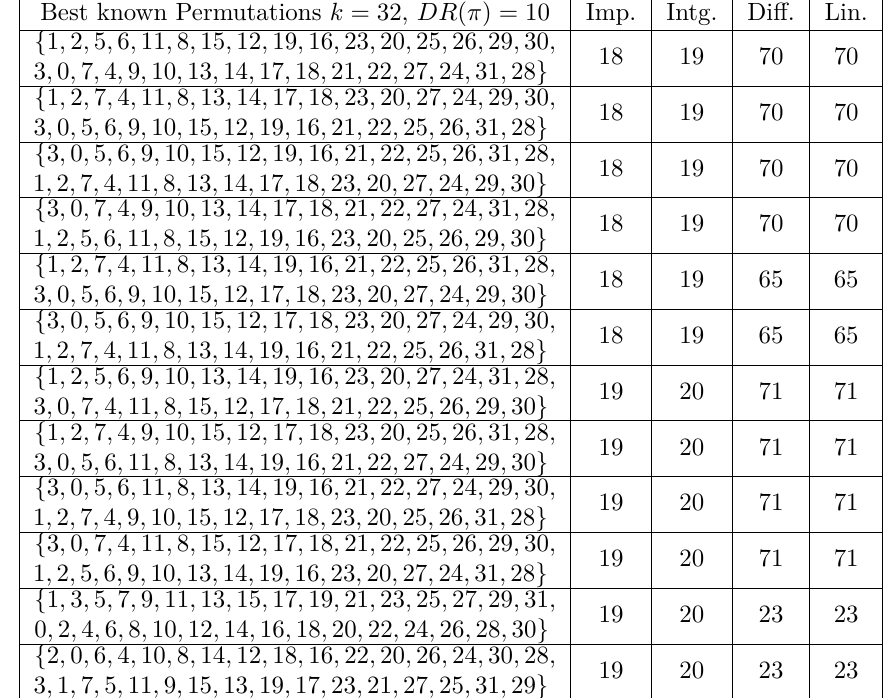
Table 22: Best known permutations k = 32 Best known Permutations k = 32, DR ( π ) = 10 Imp. Intg. Diff. Lin.